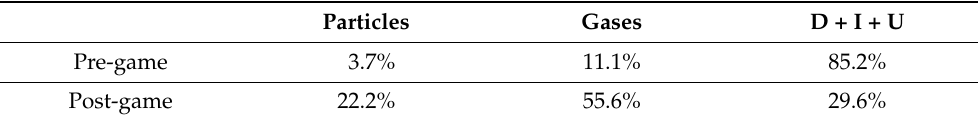
Table 3. Percentage of the 27 participants whose answers to the question “What do you think can pollute the air inside our homes?” mostly included expressions related to either particles (first column) or gases (second column). Some participants included expressions related to both types of air pollutants in their responses. The third column presents the percentage of participants which reported that they did not know how to respond (D), provided invalid responses (I), or failed to recognize that there is pollution inside our homes (U). Particles Gases D + I + U Pre-game 0.0% 29.6% 70.4% Post-game 22.2% 63.0% 37.0% Table 4. Percentage of the 27 participants whose answers to the question “What do you think is in the air when it’s polluted?” mostly included expressions related to either particles (first column) or gases (second column). Some participants included expressions related to both types of air pollutants in their responses. The third column presented the percentage of participants that reported they did not know how to respond, provided invalid responses, or that failed to recognize that there is pollution inside our homes. Particles Gases D + I + U